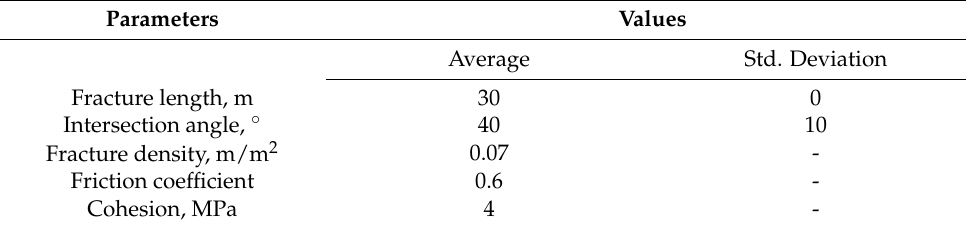
Table 2. Base case NF system parameters in the numerical